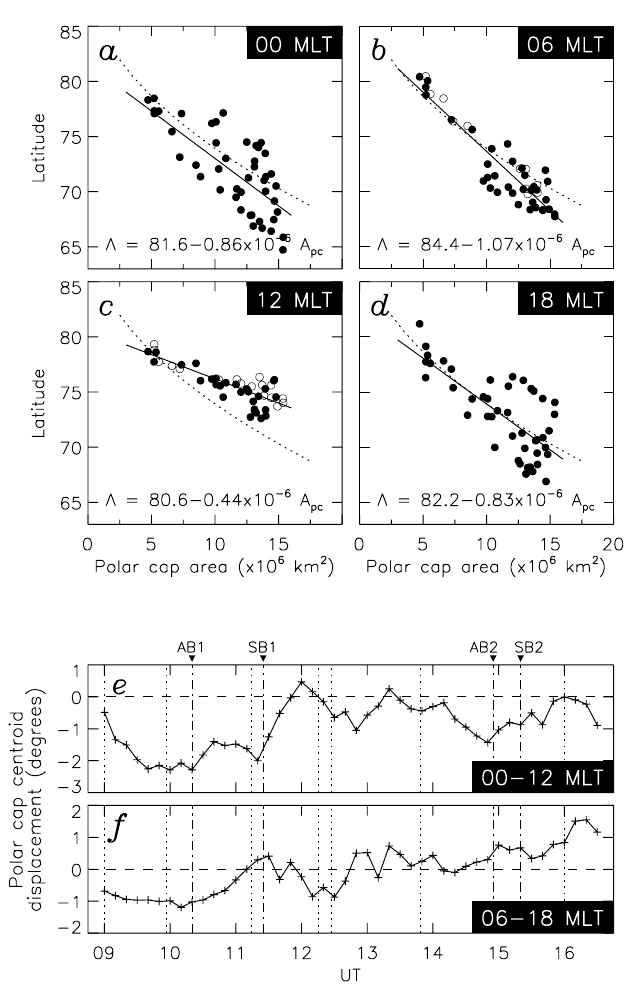
Fig. 7. (a–d) The latitude of the OCB as a function of polar cap area along the dawn and dusk, noon and midnight meridians. Linear fits to the variations are indicated by solid lines, and the fit quantified at the bottom of each panel. The latitude of the equivalent circular OCB (ECB) is shown by the dotted lines. (e) and (f) The displacement of the centroid of the polar cap from the geomagnetic pole, expressed as degrees of latitude along the noon-midnight and dawn-dusk meridians. Positive displacements are towards noon and dusk,